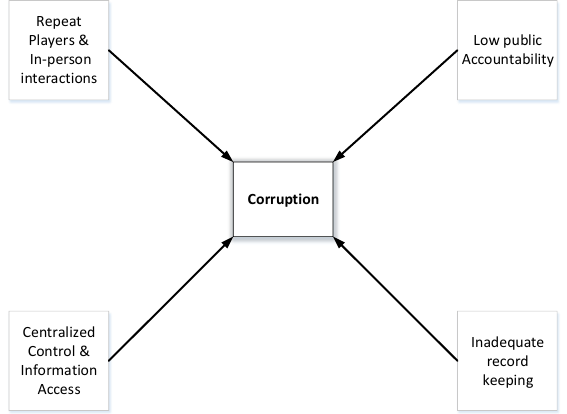
Figure 2: Framework for possible causes of corruption in public procurement; Source: Adapted from Raycraft & Lannguist (2020) and modified by the authors,